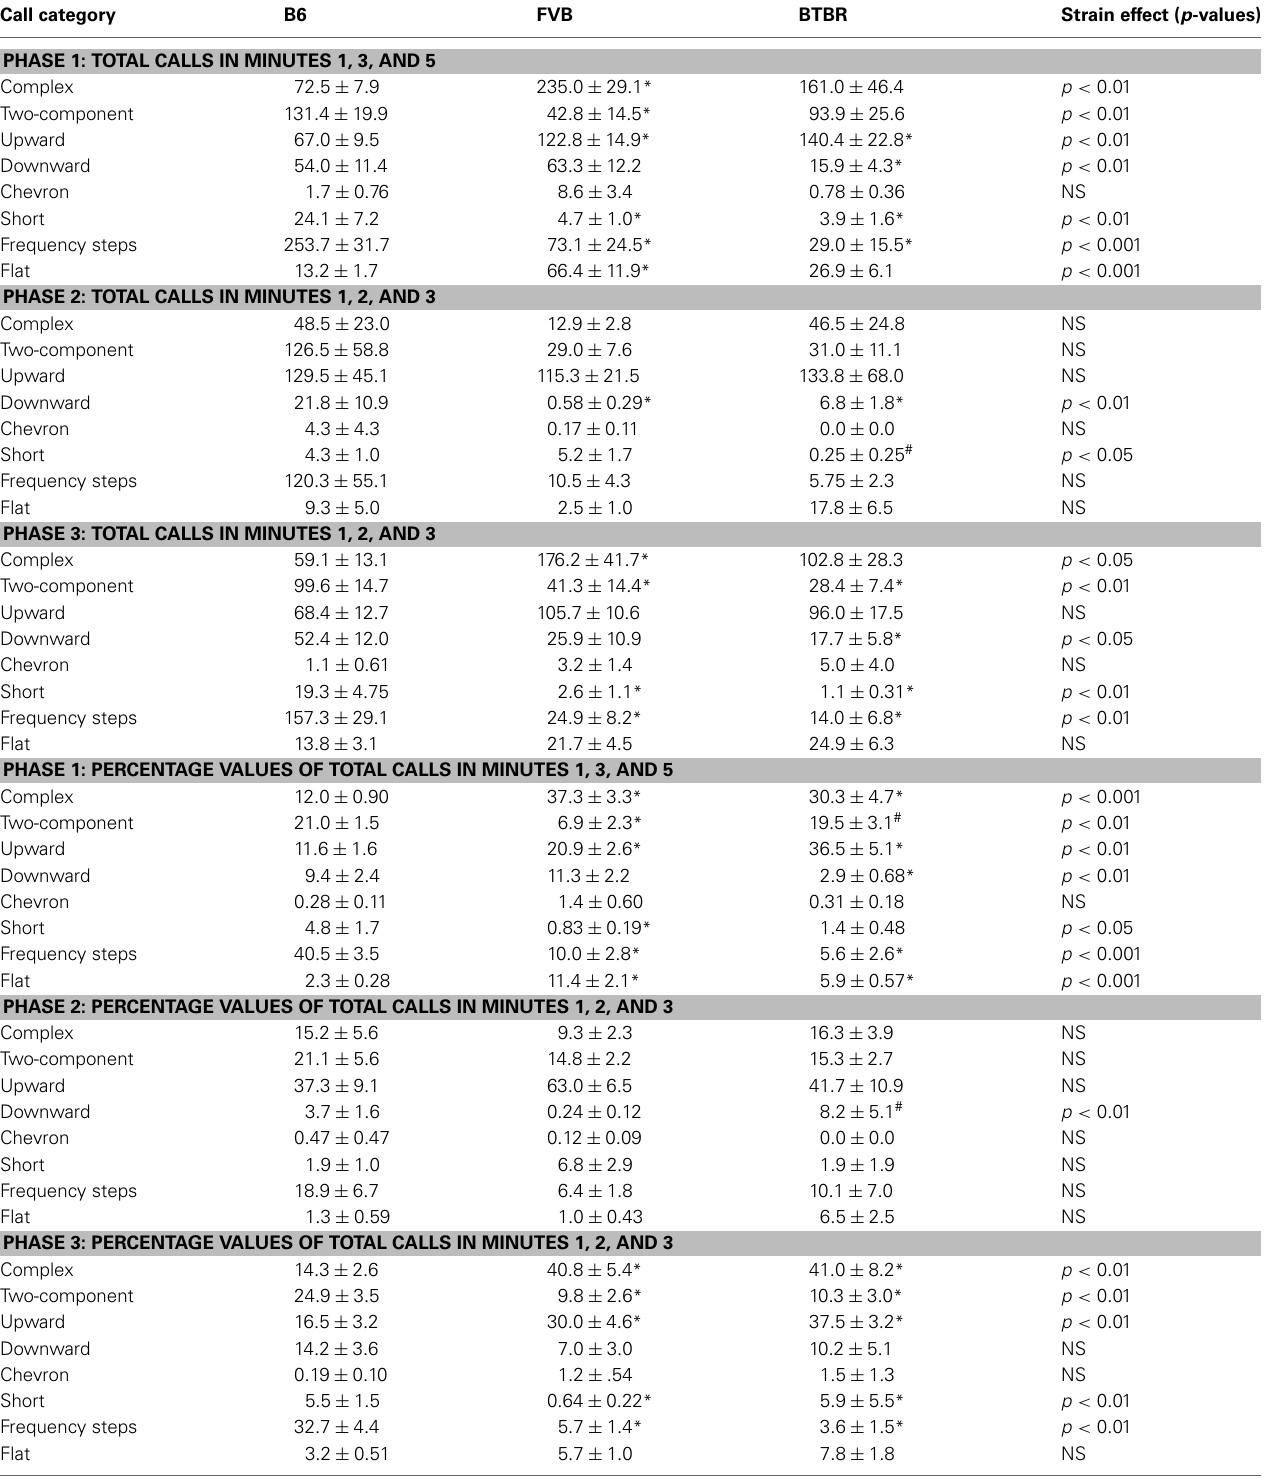
Table 1 | Strain differences in call categories during the first interaction with the female (phase 1), absence of the female (phase 2), and second interaction with the female (phase